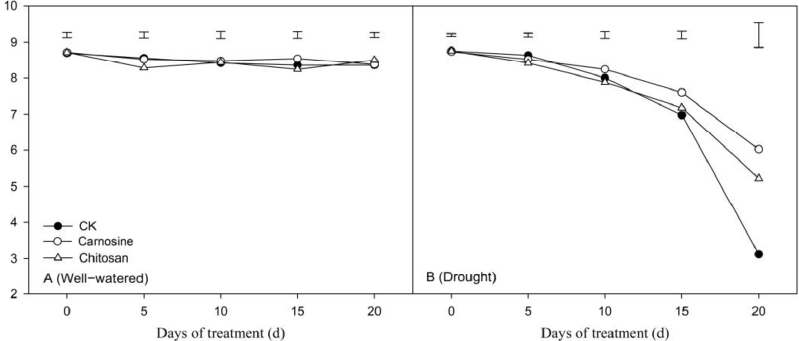
Figure 3. Effects of carnosine and chitosan on turf quality in bermudagrass. ‘CK’ represents control plants sprayed with distilled water under both well-watered and drought stress. Vertical bars represent LSD values where a significant difference ( p < 0.05) was detected among different treatments at the same time